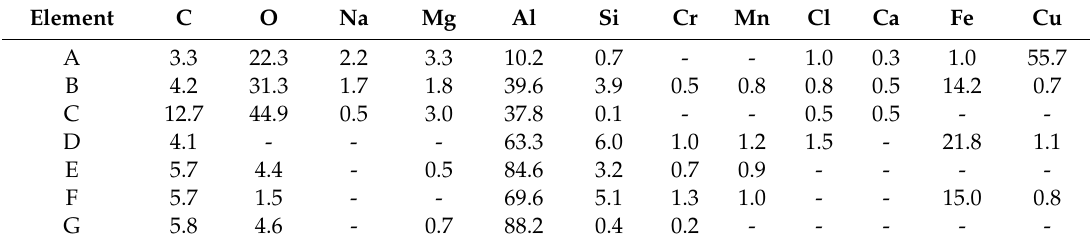
Figure 3c corresponds to the SEM image of the aluminum alloy 6061-T6 exposed in seawater at 30 days with flow after removal of the layer of corrosion products. An area on the surface damaged by cracking and fissures can be observed, while the surface exposed to seawater without flow (Figure 3d) shows less damage, with pitting holes of several diameters. In contrast, on the surface exposed to Table 3. EDS analysis (wt.%) of aluminum alloy 6061 ‐ T6 surfaces: after 30 days of exposure in laminar flow for this same time period, the pits are not clearly observable, but localised corrosion seawater under laminar flow (zones A, B, C) and after removal the layer of corrosion products (zones damage appeared in the form of fissures. This e ff ect is due to the seawater flow, which facilitates the D, E, F, G). oxygen di ff usion and its renewal at the metal interface, accelerating the corrosion process. Moreover, the seawater flow attributes to the detachment of the destroyed passive layer and the appearance of new “fresh” areas, where the oxygen di ff uses at the cathodic sites, as an oxidising agent needed for the cathodic corrosion reaction. It is also observed that, on both surfaces (Figure 3c,d), some particles remained (named as D and F), and according to EDS (Table 3), they correspond to cathodic rich in Fe [7], reported in the reference sample as α -Al(Fe,Mn,Cu)Si [36]; these intermetallic particles promoted the preferential dissolution of the aluminum matrix